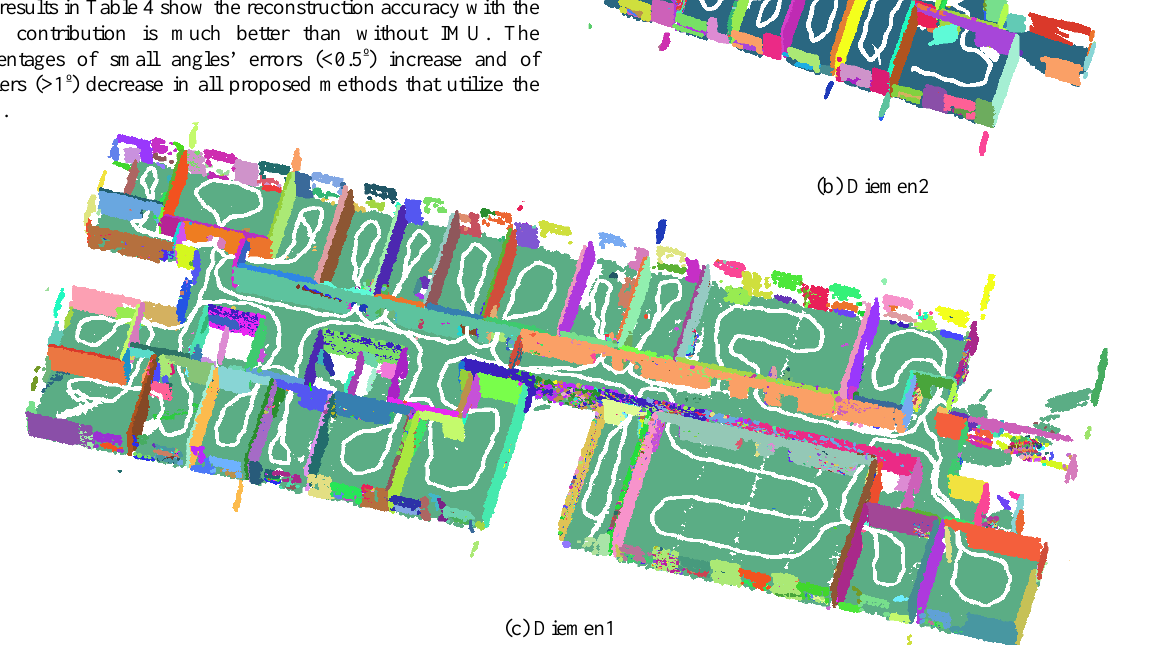
This contribution has been peer-reviewed. The double-blind peer-review was conducted on the basis of the full paper. https://doi.org/10.5194/isprs-annals-V-1-2020-223-2020 | © Authors 2020. CC BY 4.0